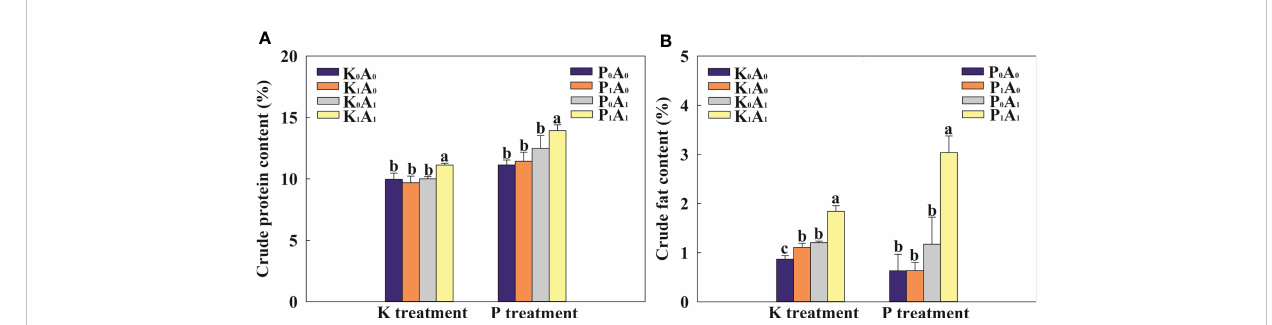
FIGURE 3 Effects of Aspergillus aculeatus on crude protein (A) and crude fat (B) contents of bermudagrass under K or P de fi ciency stress. K 0 A 0 represents no potassium feldspar and A. aculeatus treatment; K 1 A 0 represents only potassium feldspar treatment; K 0 A 1 represents only A. aculeatus treatment; K 1 A 1 represents potassium feldspar + A. aculeatus treatment; P 0 A 0 represents no tricalcium phosphate and A. aculeatus treatment; P 1 A 0 represents only tricalcium phosphate treatment; P 0 A 1 represents only A. aculeatus treatment; P 1 A 1 represents tricalcium phosphate + A. aculeatus treatment. Columns marked with the same small letter indicate insigni fi cant differences between the four treatment groups ( p <